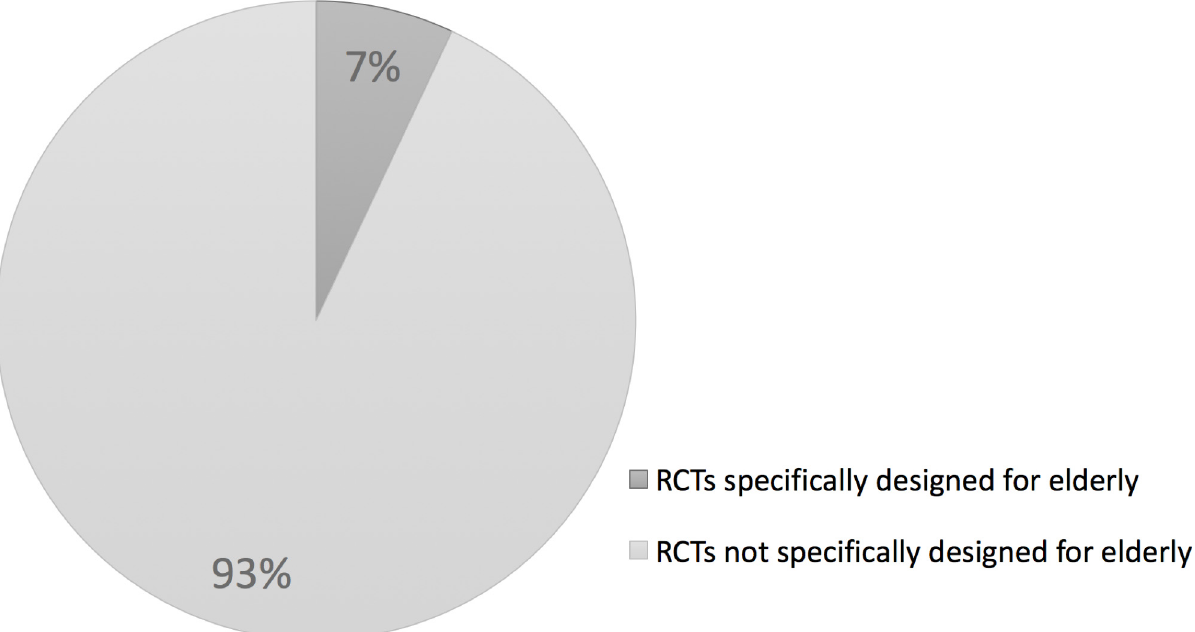
Fig 2. The representation of elderly in 1369 randomized controlled trials performed in 2012. Pie chart showing the amount and proportion of randomized controlled trials designed for elderly.